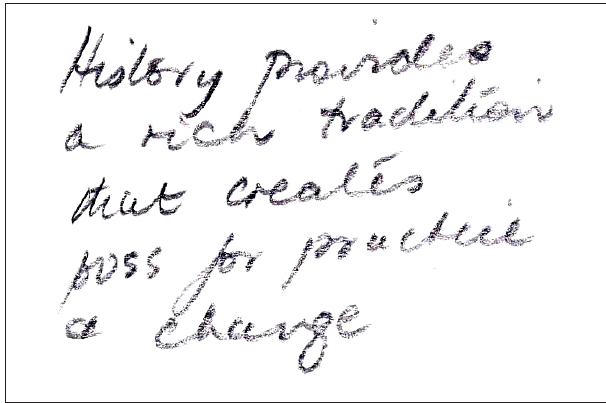
FIGURE 4: The key message has been